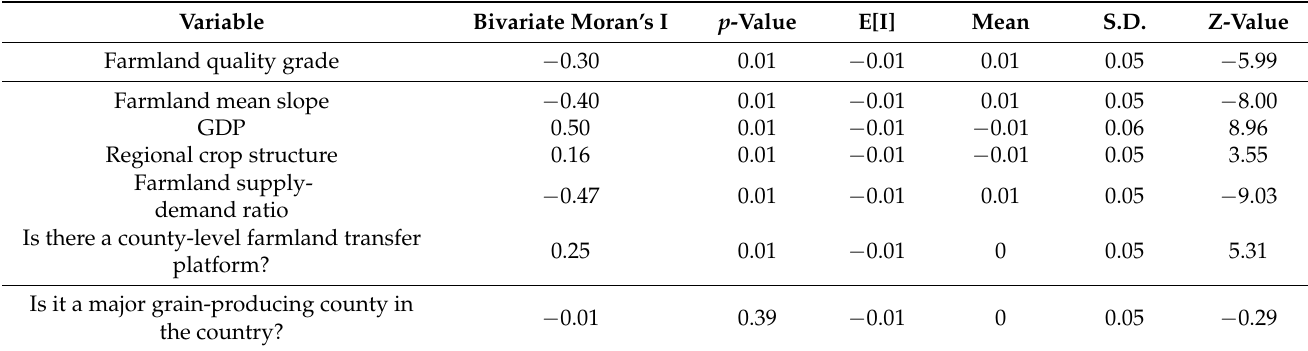
Table 3. Analysis results of bivariate Moran’s I.